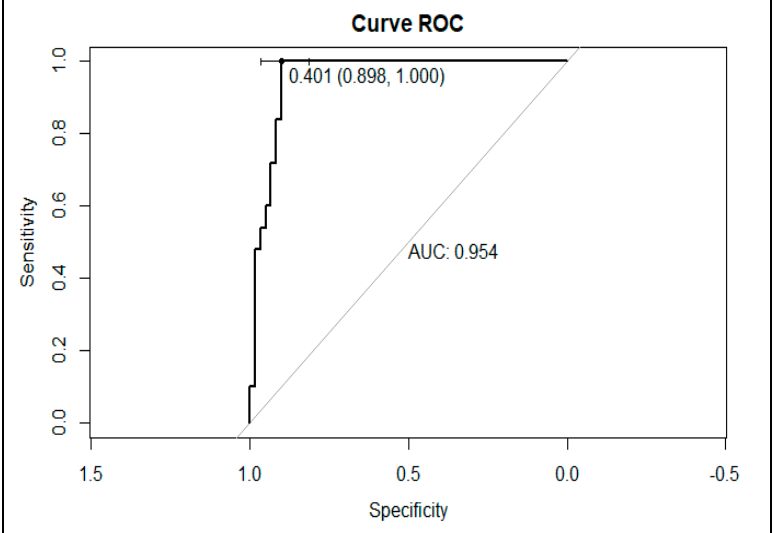
Figure 7. ROC curve of the performance of the ELISA-KPC-GMHB. This methodology obtained a sensitivity of 100% and a speci fi city of 89%, with 95% IC and a cut-o ff of 0.401.